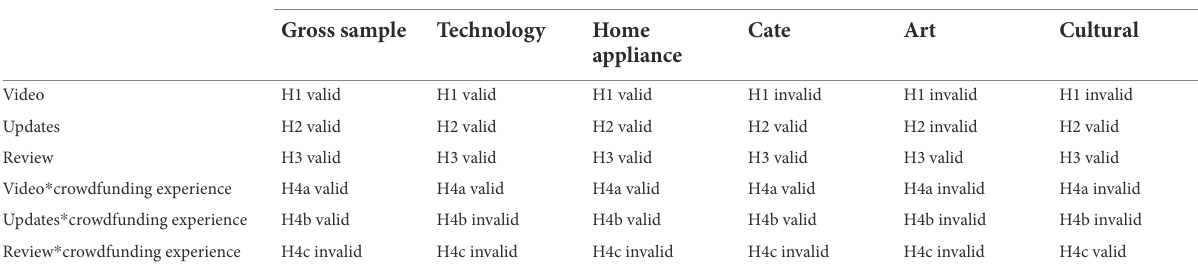
TABLE 5 Comparative analysis of empirical results of gross sample and sub-sample.